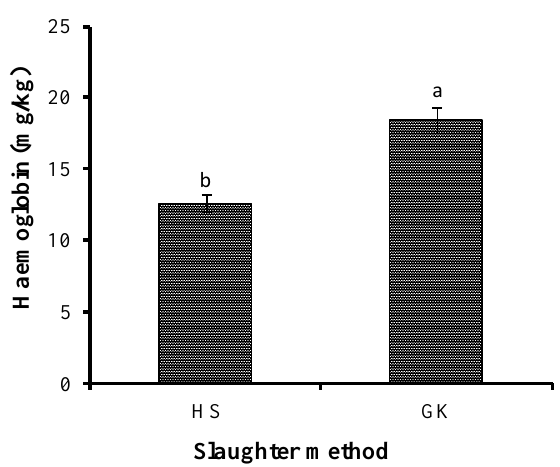
Figure 2. Differences in haemoglobin content of New Zealand white rabbits subjected to halal slaughter without stunning and gas stun-killing. HS: Halal slaughter without stunning; GK: gas stun- killing. ab Means with different letters differ significantly at